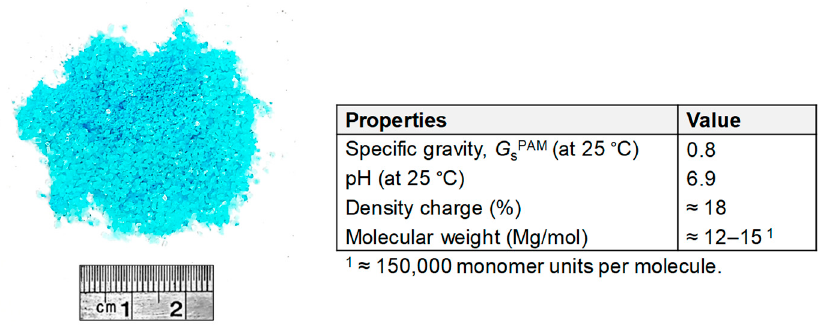
Figure A1. Anionic PAM in its granular form.